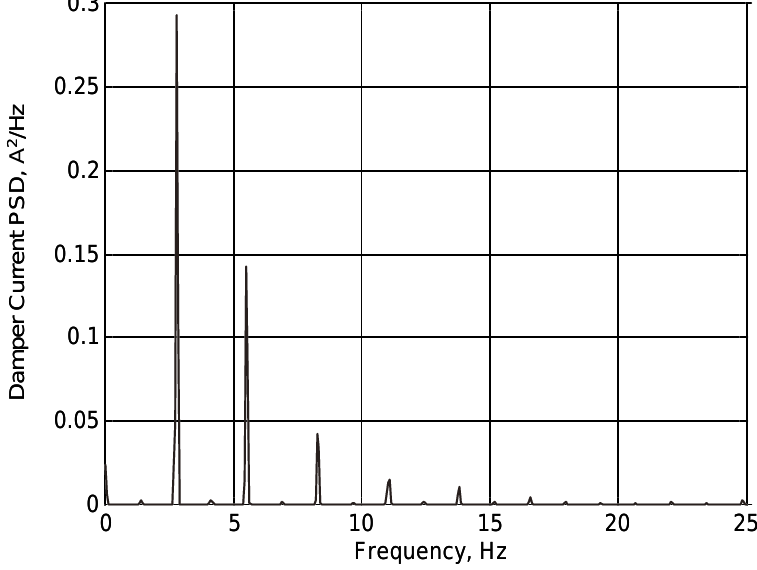
Fig. 10. Damper current power spectral density due to a 1.4 Hz pure tone excitation for a skyhook damper.